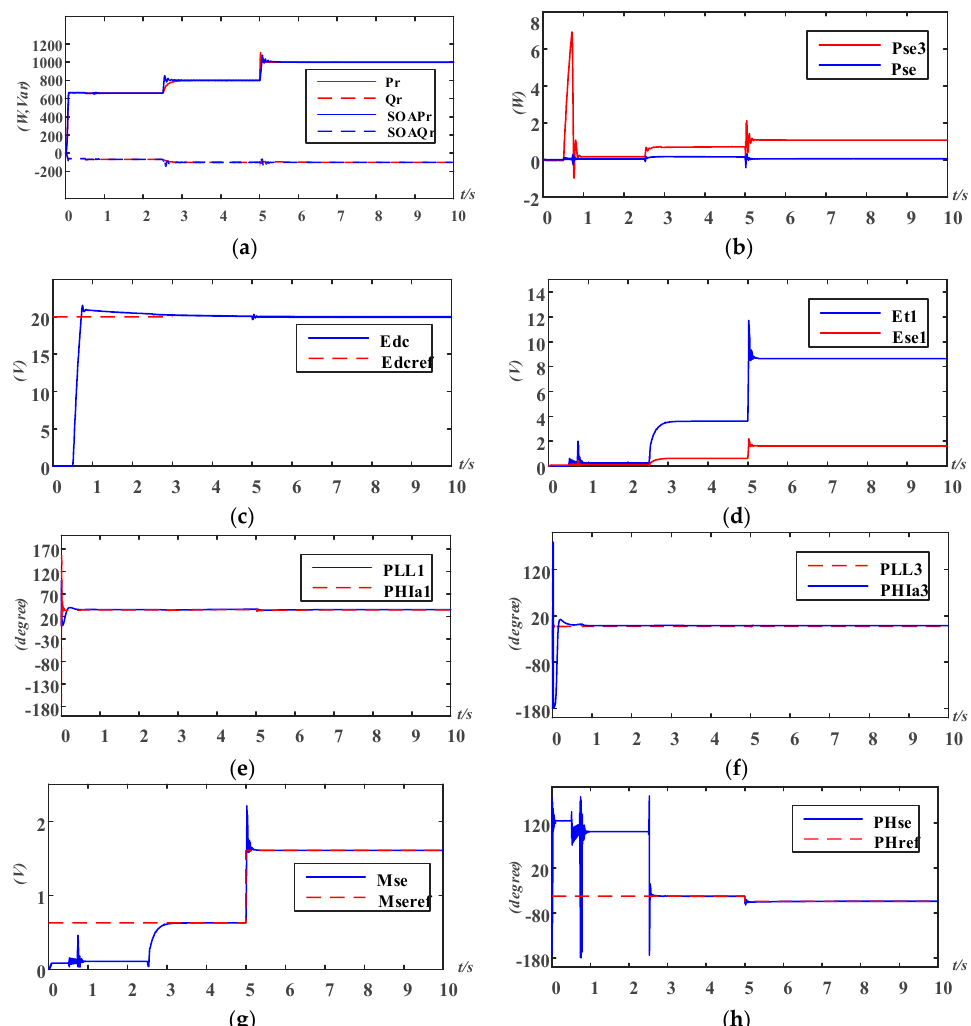
Figure 8. The simulation results of the DPFC control system. ( a ) Three-phase power flow at the receiving-end; ( b ) exchange of active power flow in the series unit; ( c ) DC capacitor voltage of each series unit; ( d ) magnitude of voltage of the single-turn transformer (STT); ( e ) SPLL result of the base-frequency line current by fast Fourier transform (FFT) component extraction; ( f ) SPLL result of the third harmonic current by FFT component extraction; ( g ) the magnitude of compensated voltage for each series unit; ( h ) the phase angle of compensated voltage for each series